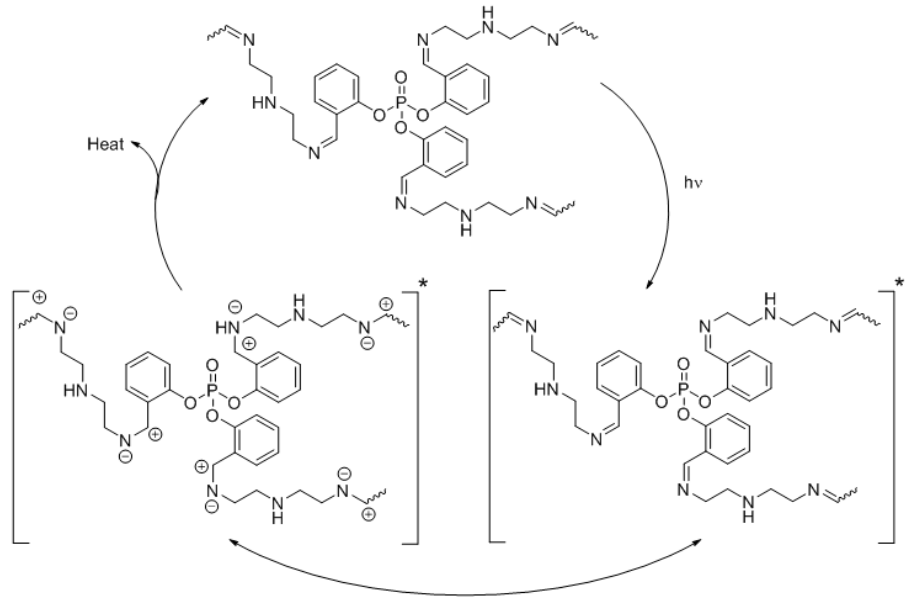
Figure 16. Polyphosphate 1 acts a UV absorber.